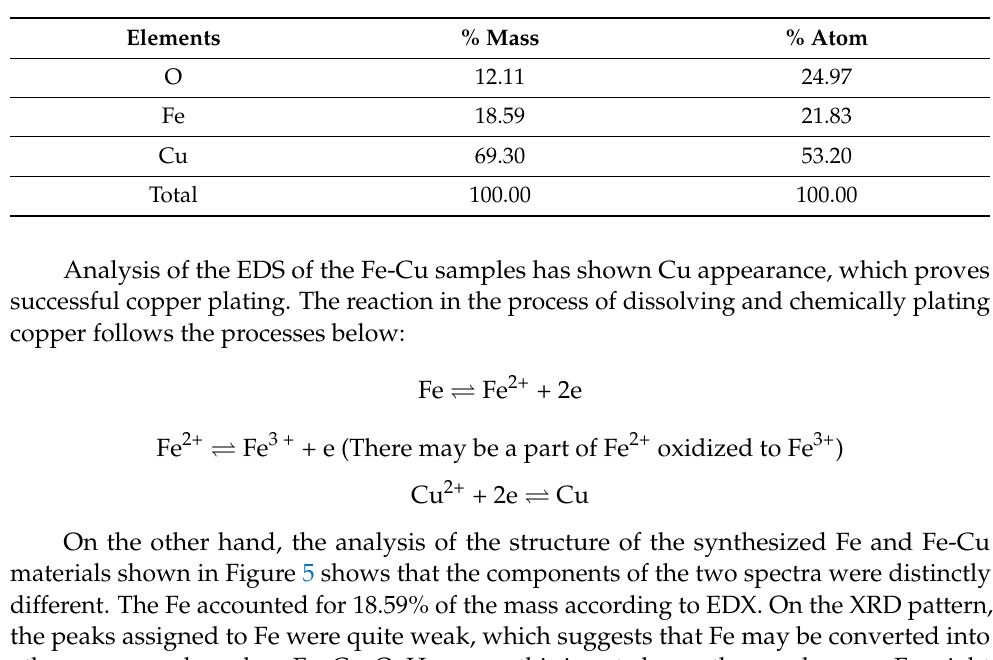
Table 2. Results of analyzing Fe sample elements.